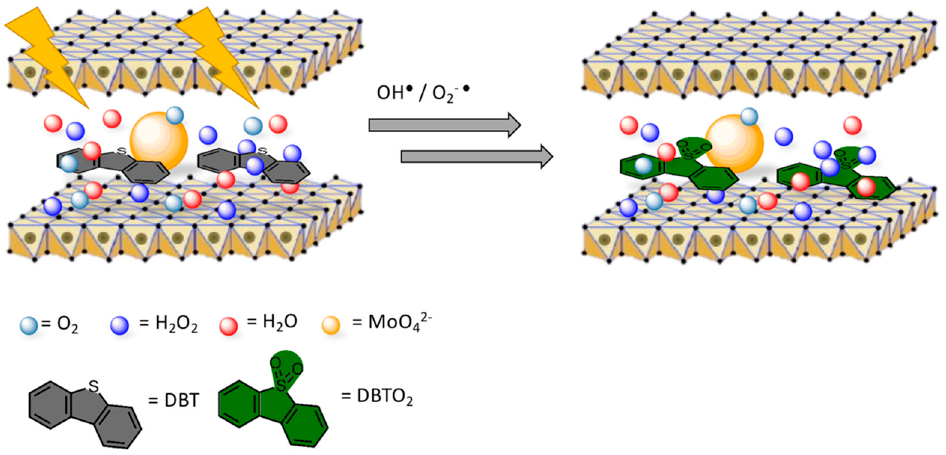
Figure 10. Catalytic oxidation of dibenzothiophene (DBT) on LaZnAl 3 -MoO 4 LDH-catalyst. Adapted from Reference [153]. Copyright 2018 Taylor and Francis.